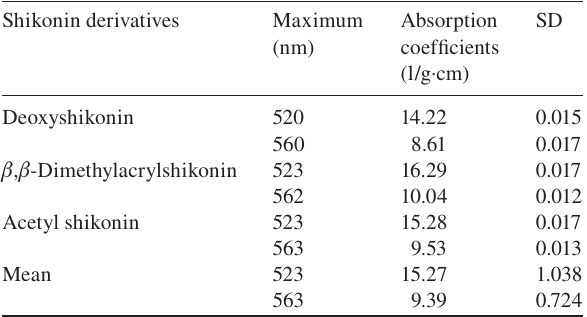
Table 1 Results of regression analysis of the proposed